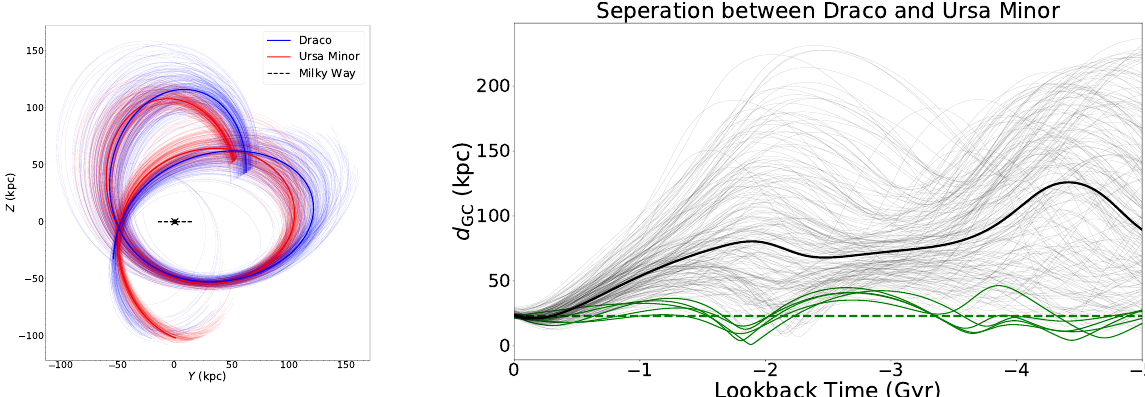
Figure 9. Possible orbits of the dSphs Draco and Ursa Minor, a proposed pair of MW satellite galaxies. The ( left-hand panel ) shows the orbits in the y–z plane of a galactocentric Cartesian coordinate system. This orientation is an almost face-on view of the orbital planes of both dwarfs (and the VPOS). Each line corresponds to one possible orbit realized by drawing from the observational uncertainties (most notably the distance and proper motion) in a Monte Carlo fashion. Draco and Ursa Minor are consistent as they share the same orbital plane, orbital direction, orbital eccentricity, and similar apo- and pericenters. The ( right-hand panel ) shows the separation between Draco and Ursa Minor resulting from different Monte Carlo realizations, integrated backwards for 5Gyr. While the proper motion uncertainties remain too high to conclusively confirm that the two satellites share a similar orbit, they are consistent with co-orbiting close to each other, because numerous realizations result in an average mutual separation below 30 kpc (highlighted in green). The orbits were integrated using the galpy package, adopting its MWpotential14 with a dark halo mass of 0.8 × 10 12 M (cid:12) as the potential of the MW